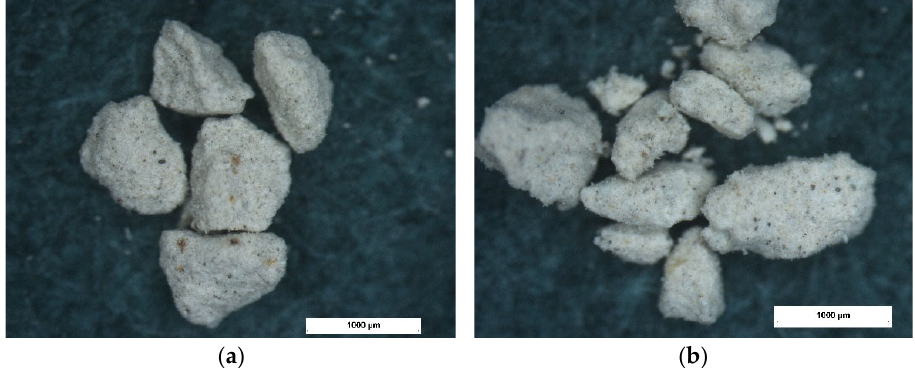
Figure 10. Microscope pictures of A ‐ 1 agglomerate ( a ) and A ‐ 2 agglomerate ( b ).